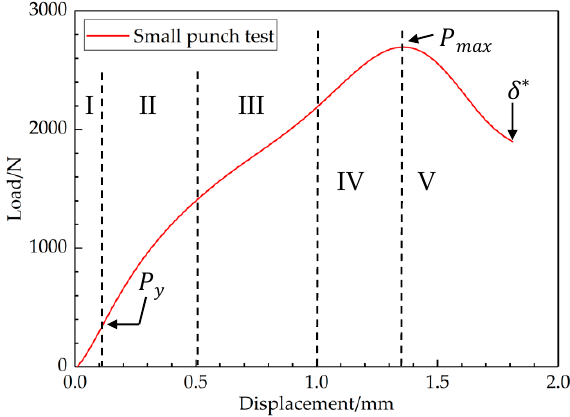
Figure 5. The main behavior zones in the SPT curve.